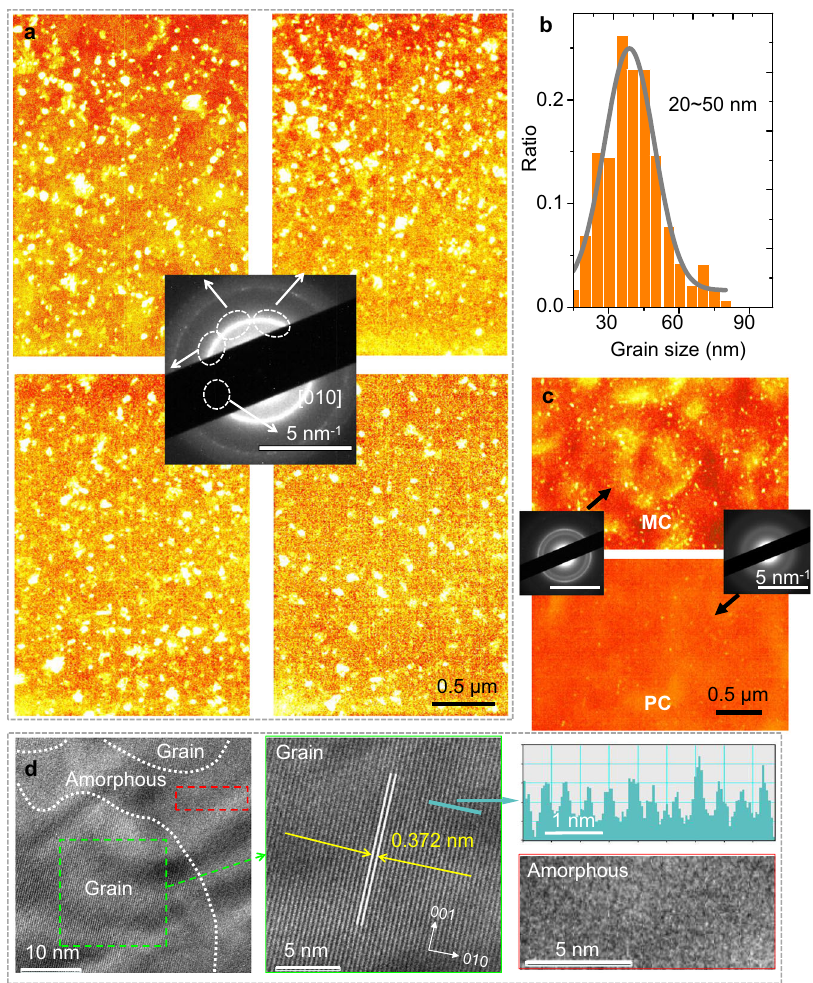
Fig. 5 TEM and HR-TEM characterizations of the PBTTT fi lms. a DF-TEM images of HC samples with four different electron-beam tilt orientations determined by the [010] face diffraction in SAED shown in the inset. b Grain size distribution in the HC sample. The distribution could be fi tted with a Gaussian distribution function centered at ~35 nm. c DF-TEM image of MC and PC samples featuring fewer and smaller grains; the inset shows the SAED of MC and PC samples. The scale bars for the DF-TEM images are 0.5 µ m, and 5 nm − 1 for the SAED images. d HR-TEM characterization of HC samples at different zoom scales and regions, with scale bar L = 10, 5, 5 nm for the left, middle, and right (down), respectively. The middle and right (down) display the detailed morphology for crystalline grain and amorphous region marked by green and red box in the left panel, respectively. The [010] pi – pi face is identi fi ed with lattice constant a = 0.372 nm, more precisely shown in upper-right, the intensity cross pro fi le of the inter chain lattice is displayed with scale bar L =